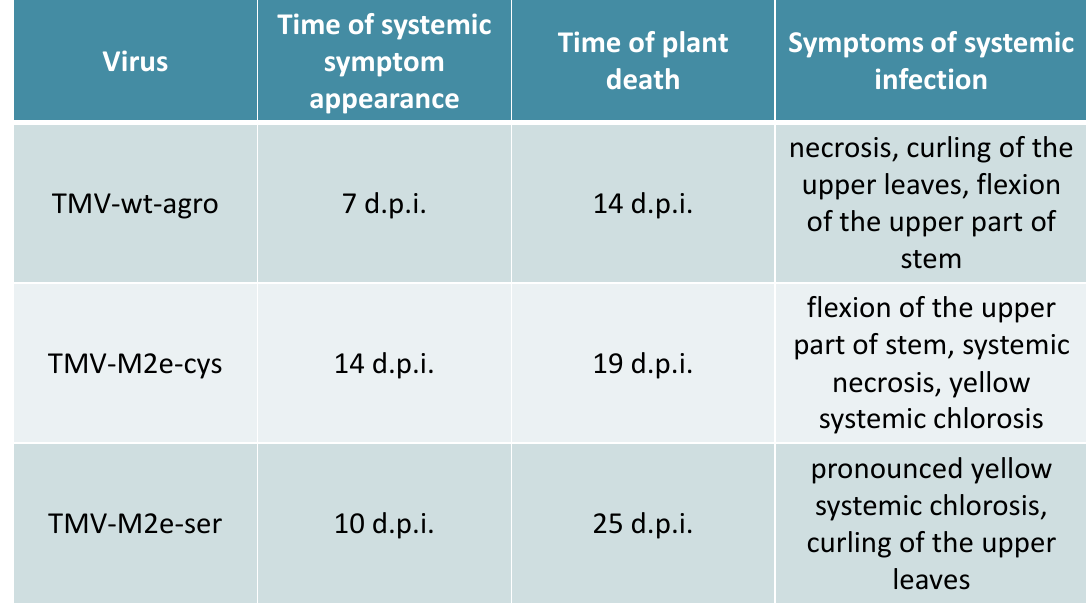
Figure 2. The comparison of symptoms and the development of Nicotiana benthamiana infections caused by agroinfiltration of binary vectors coding for TMV-wt and TMV-based recombinant